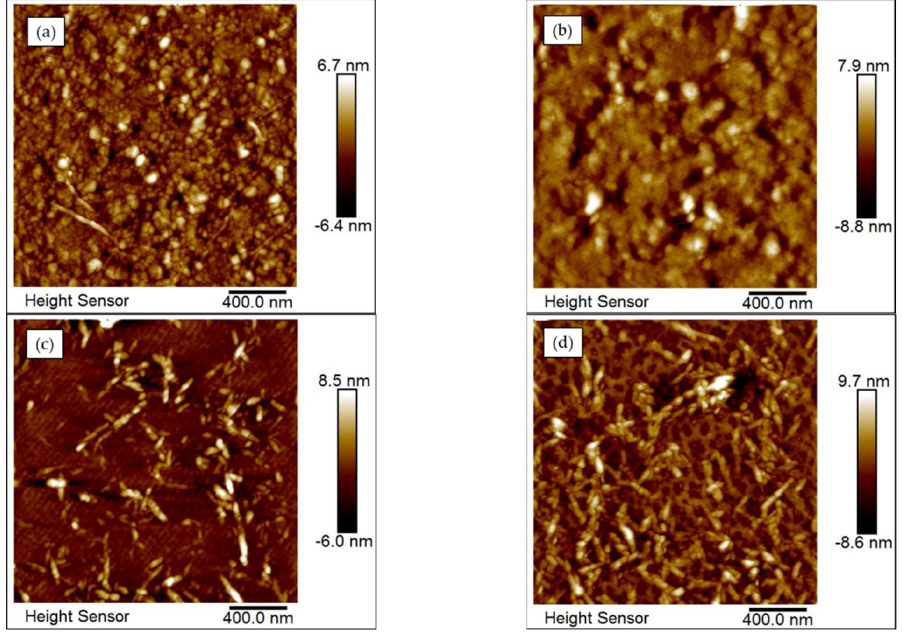
Figure 8. The 2D AFM images: ( a ) GO, ( b ) PVA, ( c ) GO–PVA thin films, and ( d ) GO–PVA thin film in contact with carbaryl.